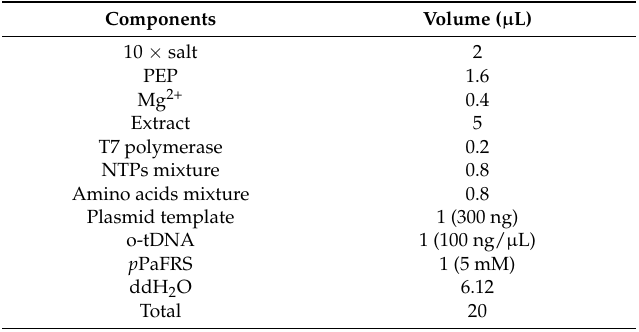
Table 1. Components of standard cell-free protein synthesis (CFPS) system.